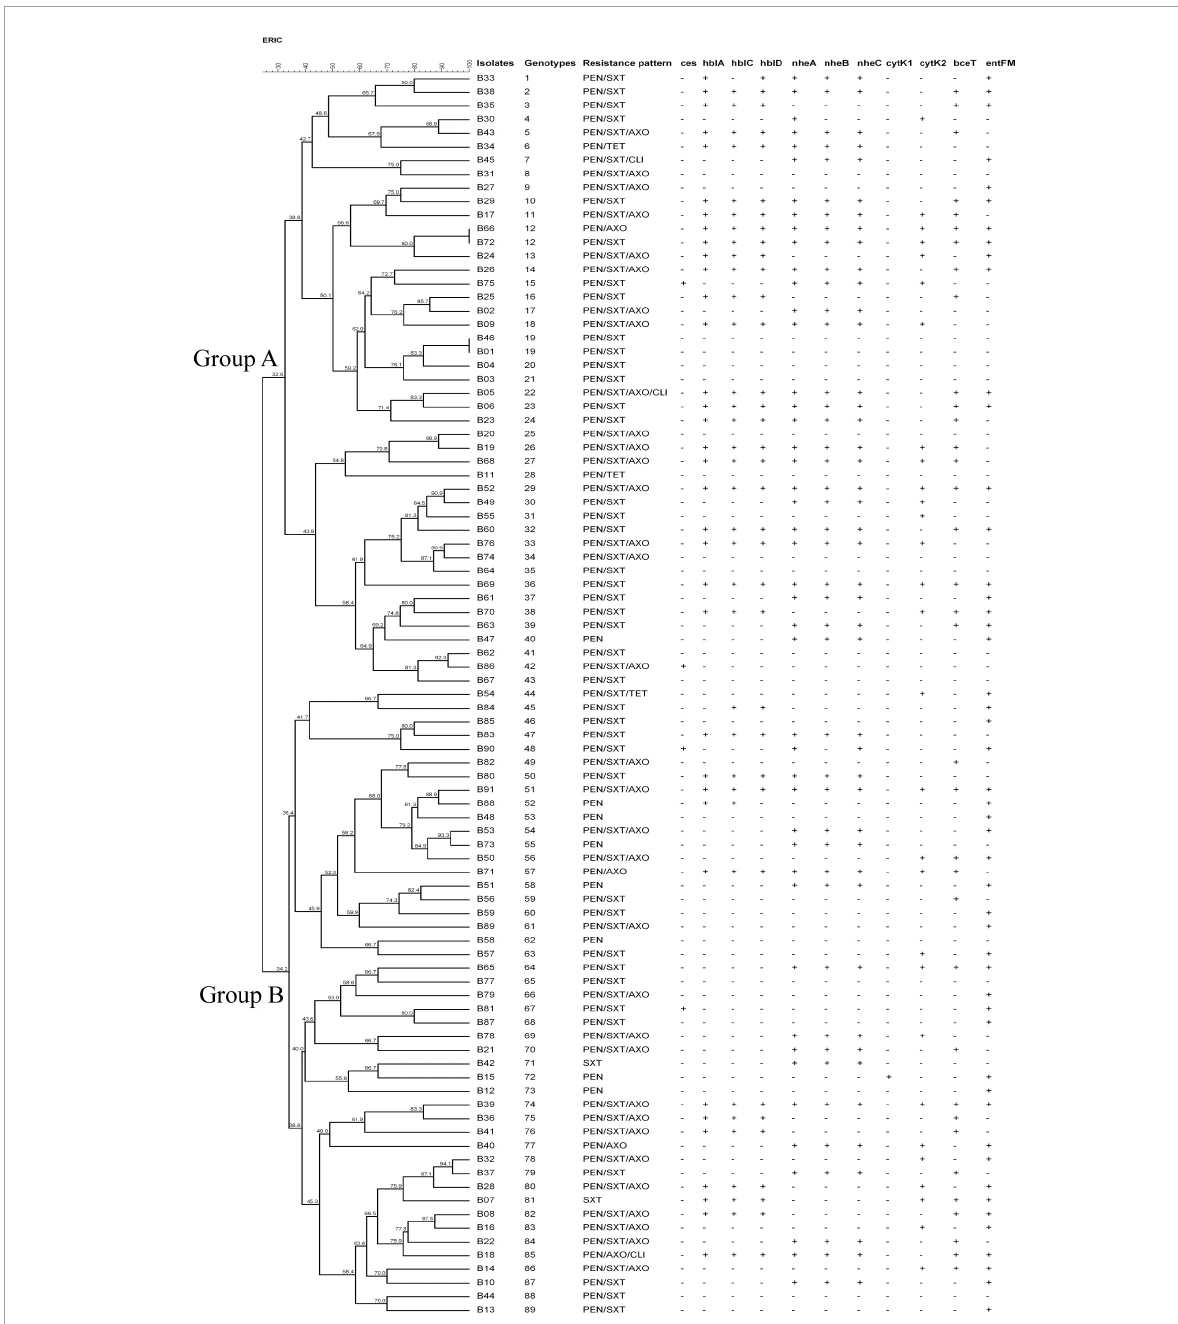
FIGURE1 Characteristics of Bacillus cereus isolated from ready-to-eat rice products. The UPGMA tree was constructed by using BioNumerics 7.6. PEN, Penicillin; SXT, Trimethoprim/Sulfamethoxazole; AXO, Ceftriaxone; TET, Tetracycline; CLI, Clindamycin.